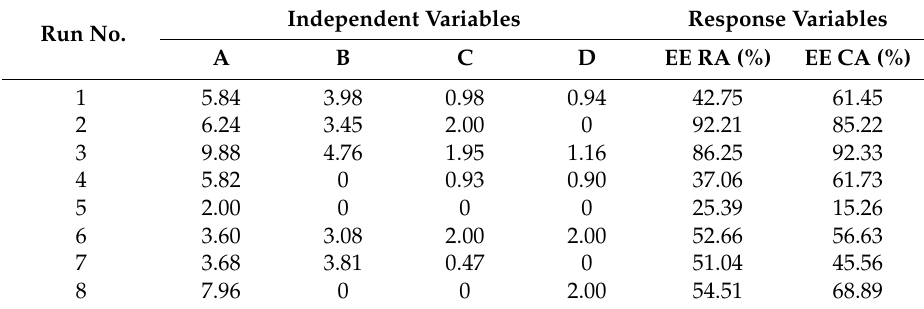
Table 1. D-optimal design with independent and response variables for the preparation of Turkish oregano-loaded